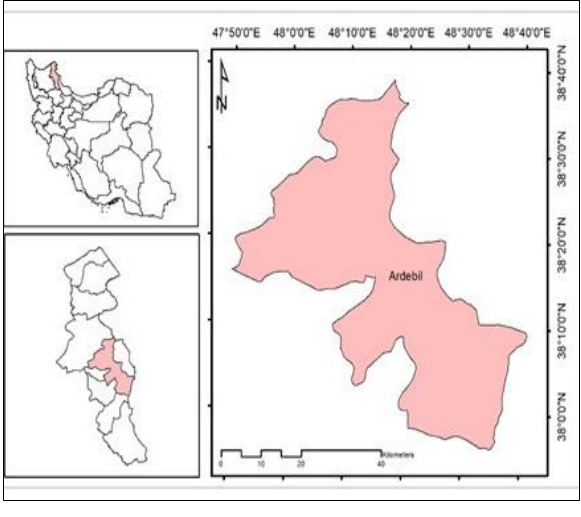
Figure 1. The study area.